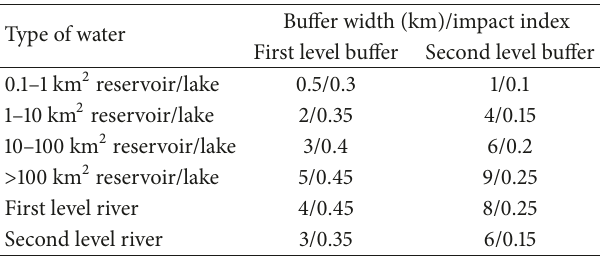
Table 3: Classification criteria for buffer widths and their